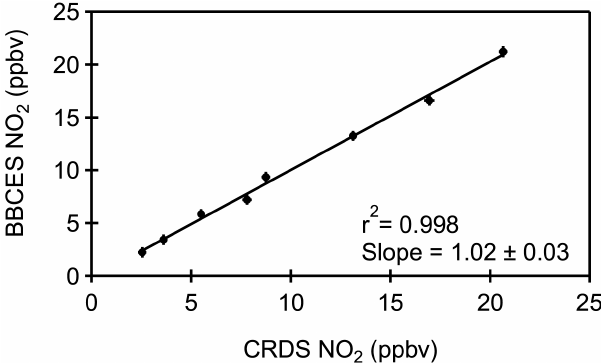
Figure 4. Correlation plot comparing NO 2 measurements from the BBCEAS and CRDS instruments during 1min standard additions. The slope is 1 . 024 ± 0 . 027 with intercept of − 0 . 20 ± 0 . 32ppbv (black line) and r 2 = 0 . 998.